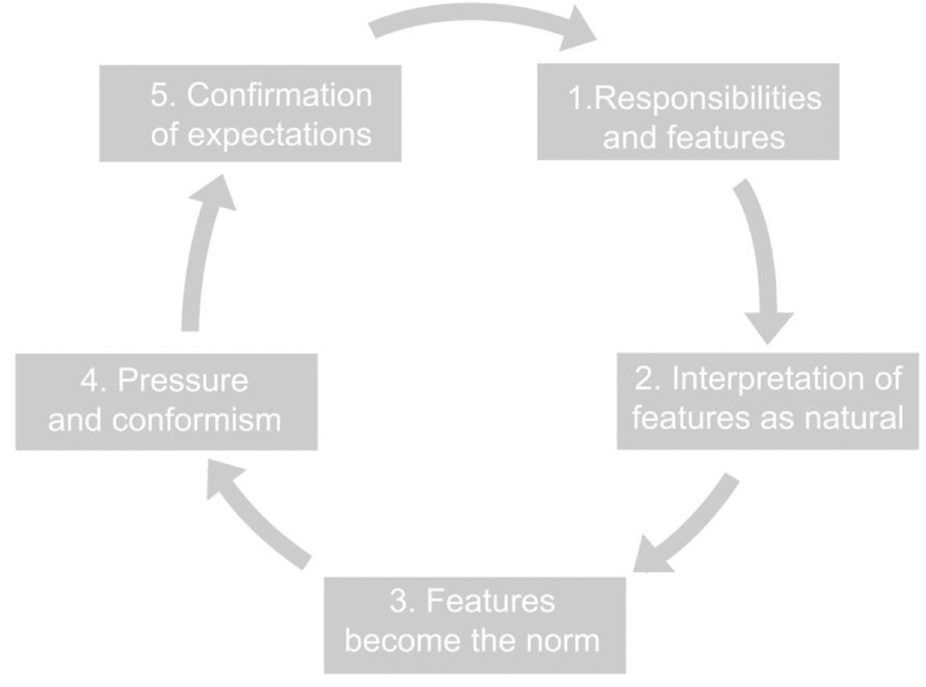
Fig 1. The vicious circle of